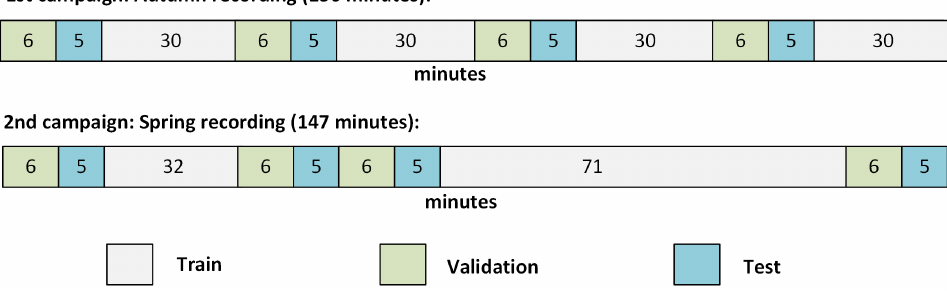
Figure 3. Duration and temporal splitting of the Train, Validation, and Test sets of the